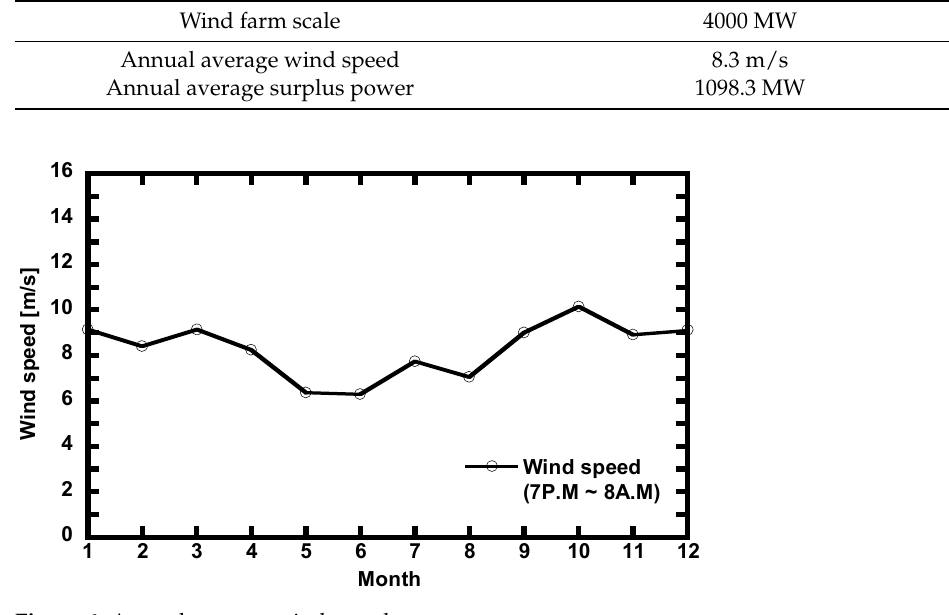
Figure 6. Annual average wind speed. Table 5. Data for the offshore wind farm.